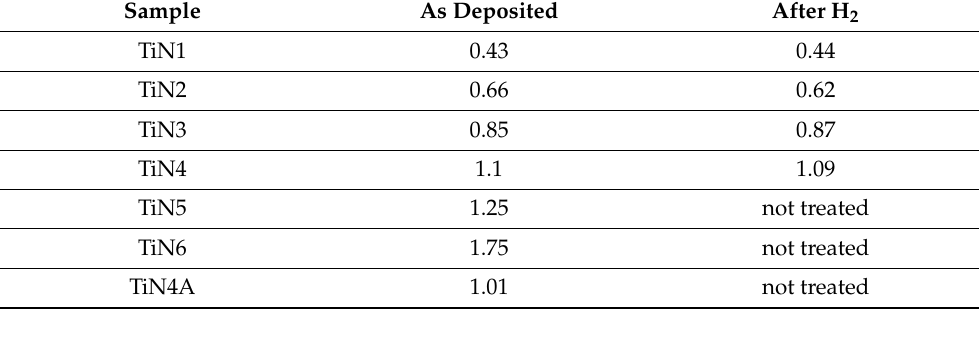
Table 2. SEM-EDS compositional analyses of TiN x samples deposited on silicon.